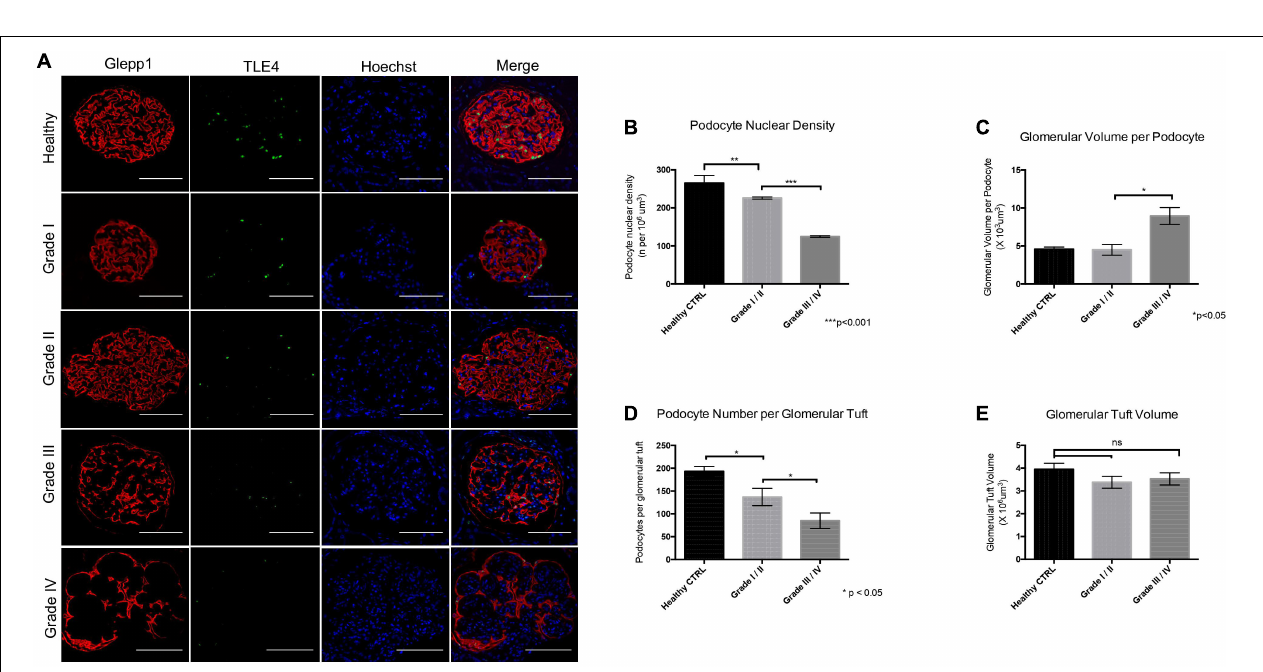
FIGURE 2 | Podometric analysis demonstrates correlation between reduced podocyte density and disease severity in Diabetic Nephropathy (A) Representative images of glomeruli from healthy control tissue and Grades I–IV of Diabetic Nephropathy cohort. GLEPP1 (red) was used as a glomerular marker, TLE4 (green) was used as a nuclear podocyte marker, Hoechst (blue) was used as a nuclear marker. (B) Podocyte nuclear density (n per 10 6 um 3 ) in healthy vs. Grade I/II vs. Grade III/IV of Diabetic Nephropathy (** p < 0.01 and *** p < 0.001). (C) Glomerular volume per podocyte ( × 10 3 um 3 ) in Grade I/II vs. Grade III/IV in Diabetic Nephropathy (* p < 0.05). (D) Podocyte number per glomerular tuft in Grade I/II vs. Grade III/IV in Diabetic Nephropathy (* p < 0.05). (E) Glomerular tuft volume (x10 6 um 3 ) in Grade I/II vs. Grade III/IV in Diabetic Nephropathy (ns, not significant).